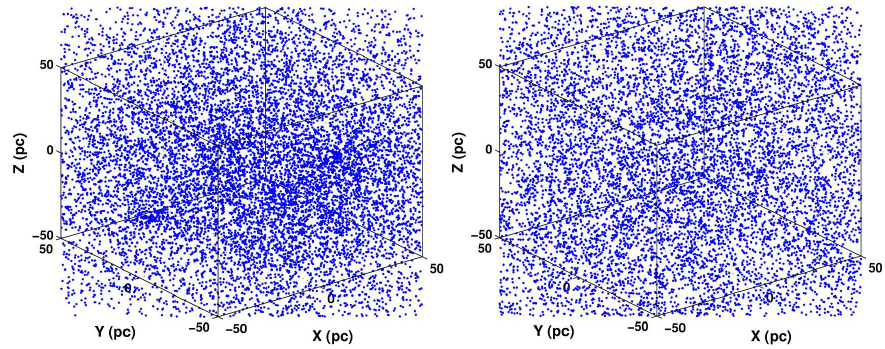
Fig. 1. Distribution of stars in the solar neighborhood according to the data of the Geneva-Copenhagen Survey (left-hand panel) and uniform random distribution of points in the same volume (right-hand panel). Here X; Y; Z are Galactic Cartesian